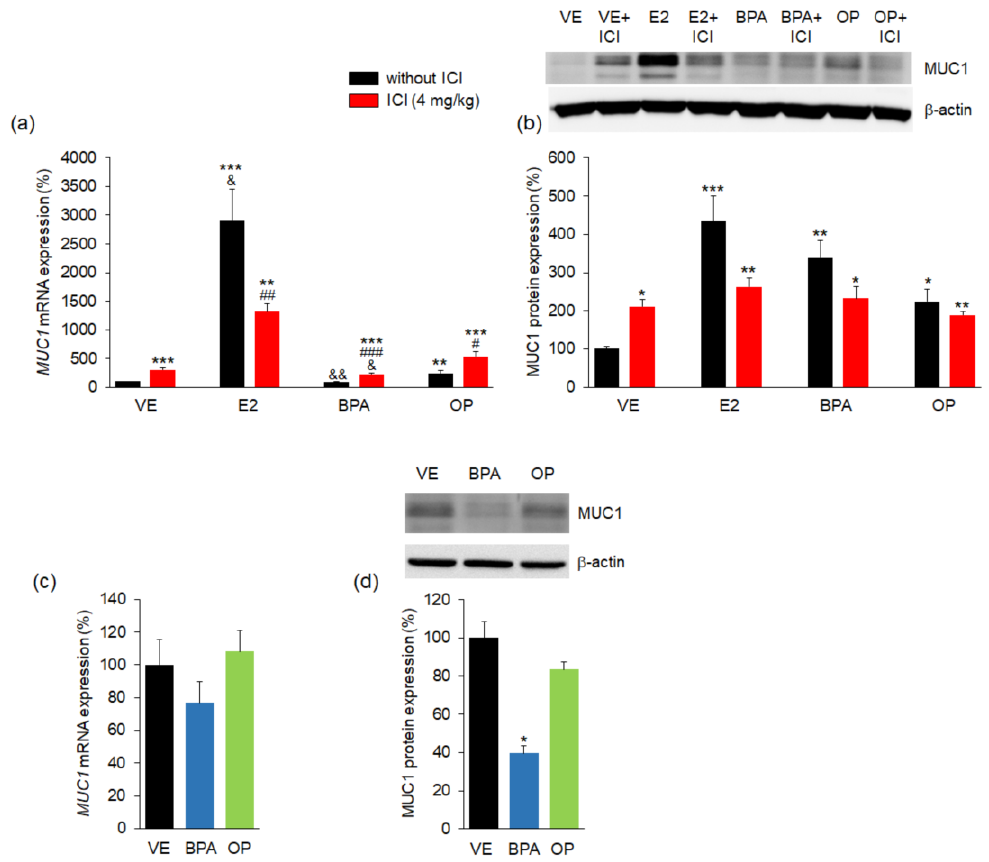
Figure 3. BPA, OP, and E2 increased the expression of MUC1 in maternal uterus and implantation sites. The expression of MUC1 was measured by real-time PCR and was normalized to that of 18S ribosomal RNA (RN18S). Expression of MUC1 protein was investigated by western blotting and was normalized by β -actin. Histograms show quantification of western blots. In uterus, ( a ) the expressions of MUC1 mRNA in maternal uterus were markedly high in the E2, OP, and EDs + ICI groups; ( b ) Protein levels of MUC1 were significantly high in all administered groups. mRNA levels of MUC1 were significantly higher in the combination BPA + ICI and OP + ICI than that in BPA- and OP-alone; In implantation sites, ( c ) there were no differences in the expression of MUC1 mRNA; ( d ) Protein level of MUC1 was significantly decreased by BPA treatment. Statistical significance was determined by two-way ANOVA. * p < 0.05 vs. VE, ** p < 0.01 vs. VE, *** p < 0.001 vs. VE, # p < 0.05 EDs + ICI vs. EDs, ## p < 0.01 EDs + ICI vs. EDs, ### p < 0.001 EDs + ICI vs. EDs, & p < 0.05 vs. ICI, && p < 0.01 vs. ICI. n = 5 mice per group for uterus, n = 3 mice per group for implantation sites. Treatments: E2; 40 µg/kg/day, BPA; 100 mg/kg, OP; 100 mg/kg, ICI; 4 mg/kg.